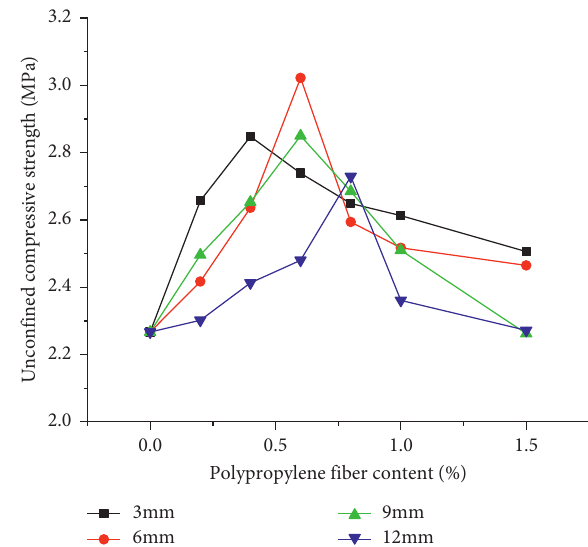
Figure 11: The relationship between unconfined compressive strength and polypropylene fiber